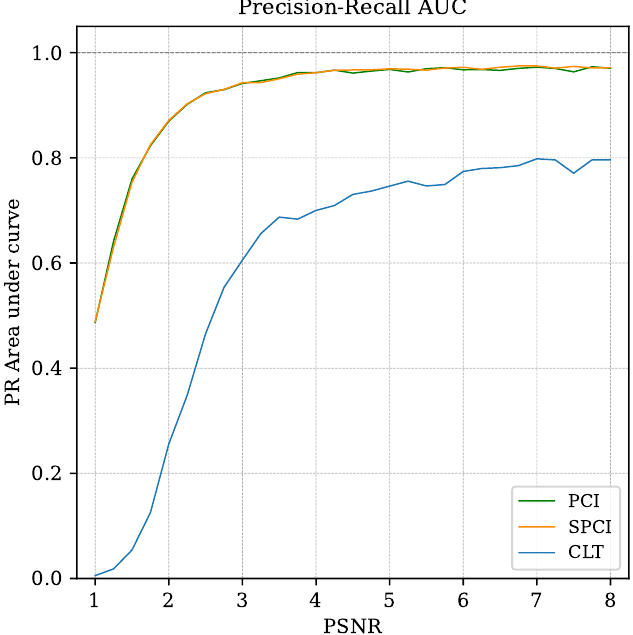
Figure 14. Area-under-curve (AUC) for PCI, SPCI and CLT PR curves. The abscissa axis represents the PSNR. Unit AUC value indicates perfect pattern recognition capabilities under the tested